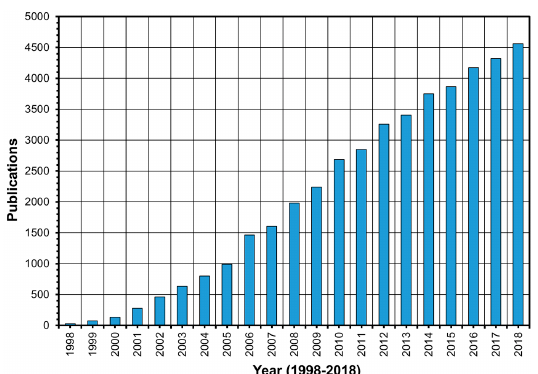
Figure 1. The number of publications in the last two decades showing the increasing interest in ionic liquids (Web of Science, November 2019, ionic liquids).